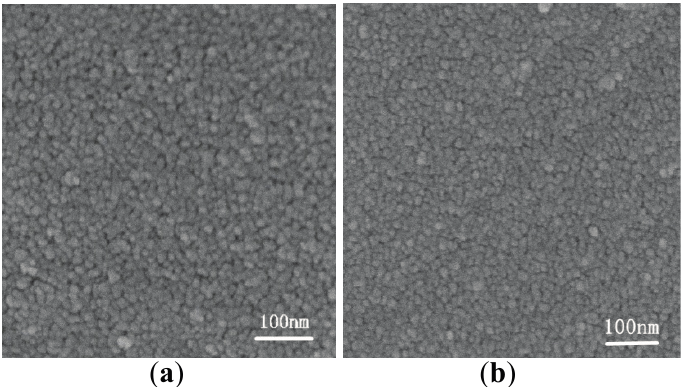
Figure 2. SEM images of ( a ) W: unassisted SnO 2 nanomaterial; ( b ) A: acetone-assisted SnO 2